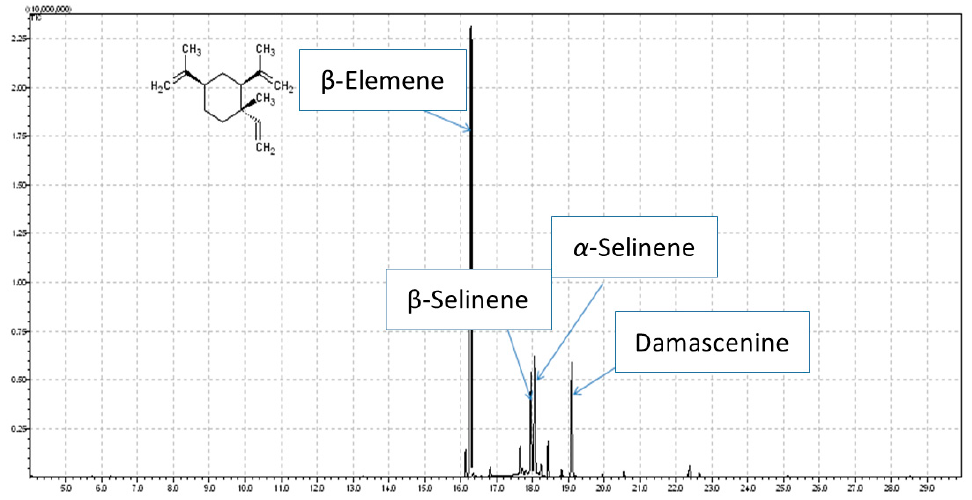
Figure 1. GC-MS chromatogram of Nigella damascena essential oil and chemical structure of β -elemene.